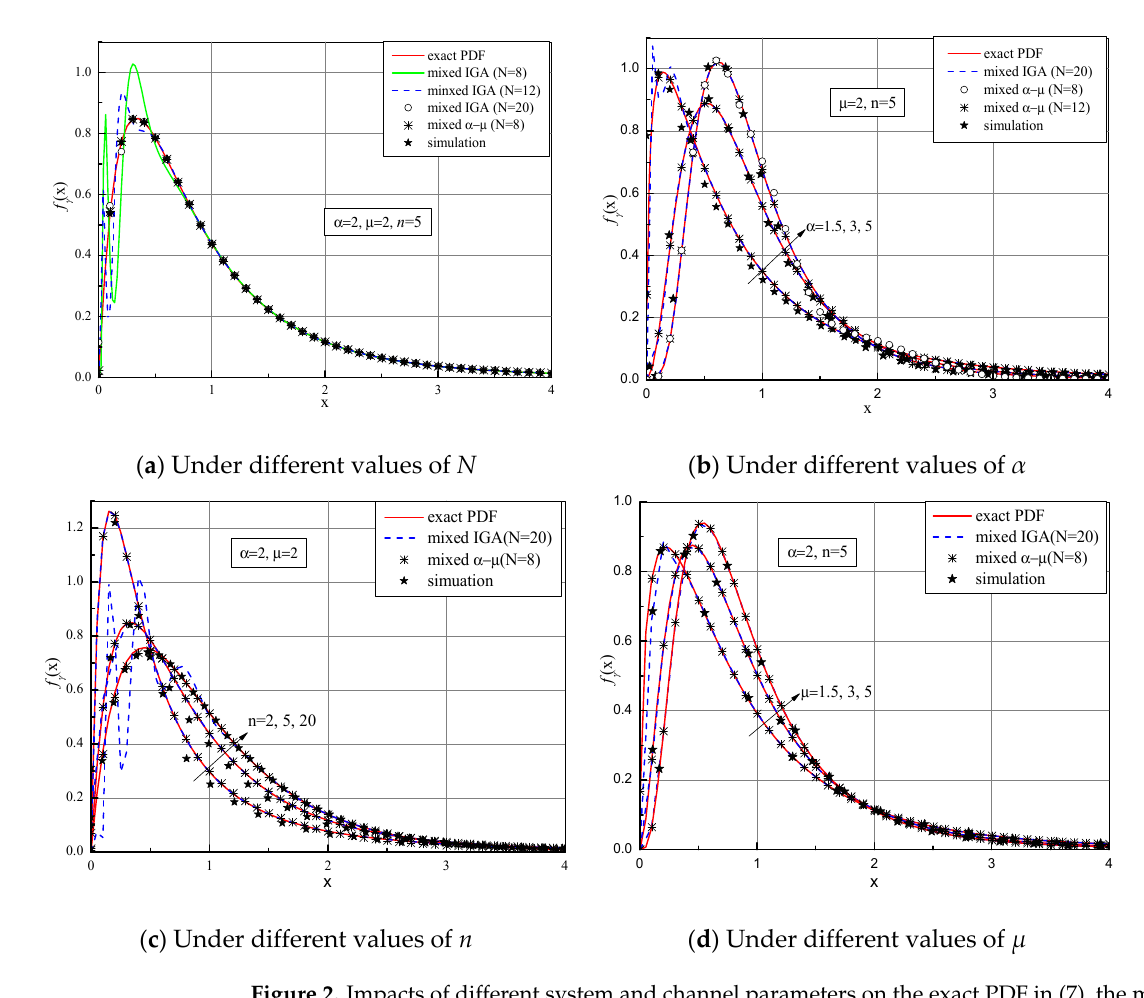
Figure 2. Impacts of different system and channel parameters on the exact PDF in (7), the mixed α - μ PDF in (10), and the mixed IGA PDF in (13). Table 1. Comparisons of the MSE and the KLD for the exact PDF and the mixed PDFs with different channel parameters ( α , μ , and n ) and the truncated term ( N ).